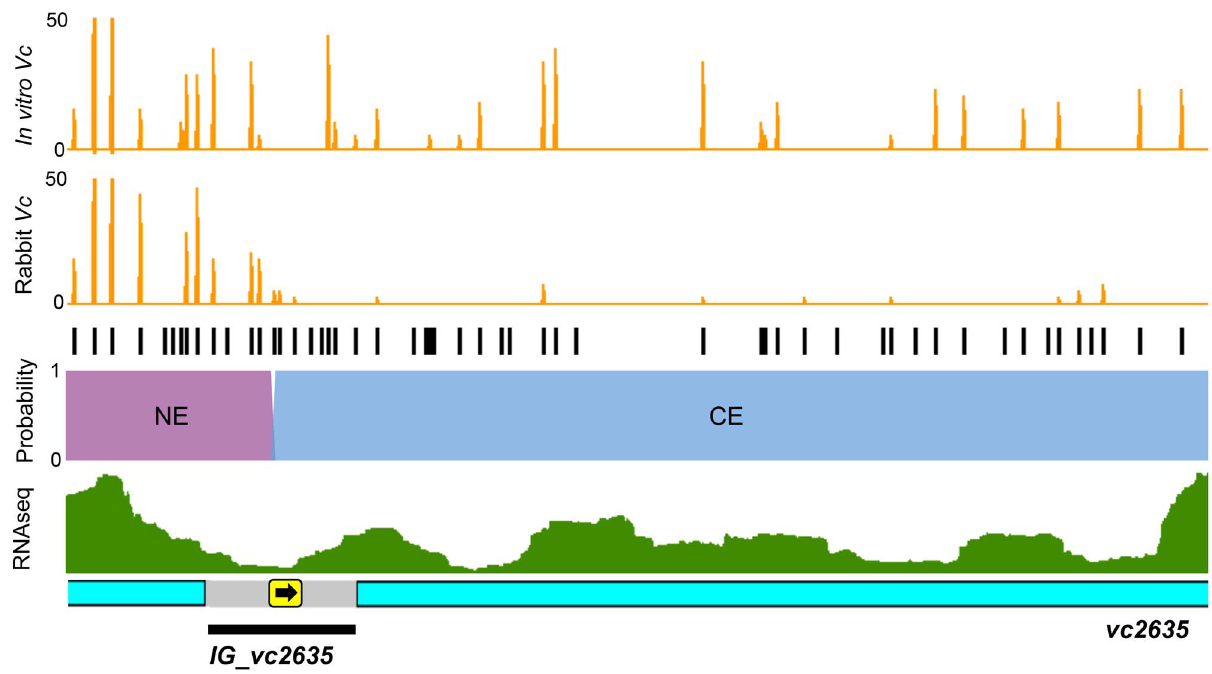
Figure 5. Con-ARTIST decodes intergenic regions of conditional essentiality. The vc2635 locus, which encodes penicillin-binding protein 1A, was defined as conditionally essential in vivo , while an upstream intergenic region, IG_vc2635 , was found to be domain conditionally essential by Con-ARTIST. The reads at each insertion in the in vitro and in vivo grown libraries are shown in orange and all potential transposon insertion sites (TA dinucleotides) are in black. The probabilities for each insertion being conditionally essential (CE, blue) or non-essential (NE, purple) in vivo (no probabilities for conditional enrichment or essential for in vitro growth were found) are overlaid on the locus. Previously published RNAseq data [23] was also overlaid on the locus (green). The part of the intergenic region identified as conditionally essential overlaps with the predicted 2 10 and 2 35 boxes (yellow box with arrow) and putative 5 9 UTR sequence. The region presented shows reads spanning nucleotides 2805484 to 2806320 ( , 800